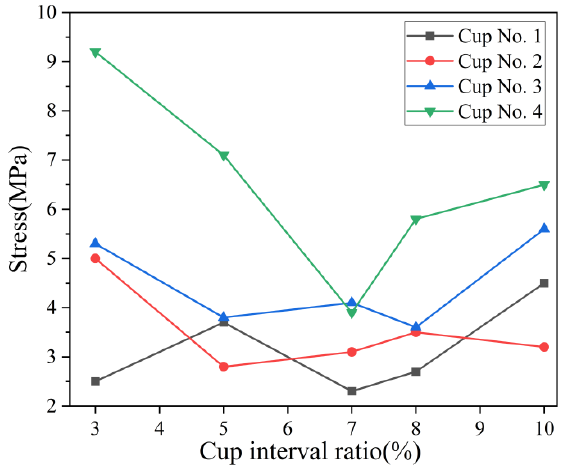
Figure 10. Comparison of the maximum stress of different cup spacing ratios.